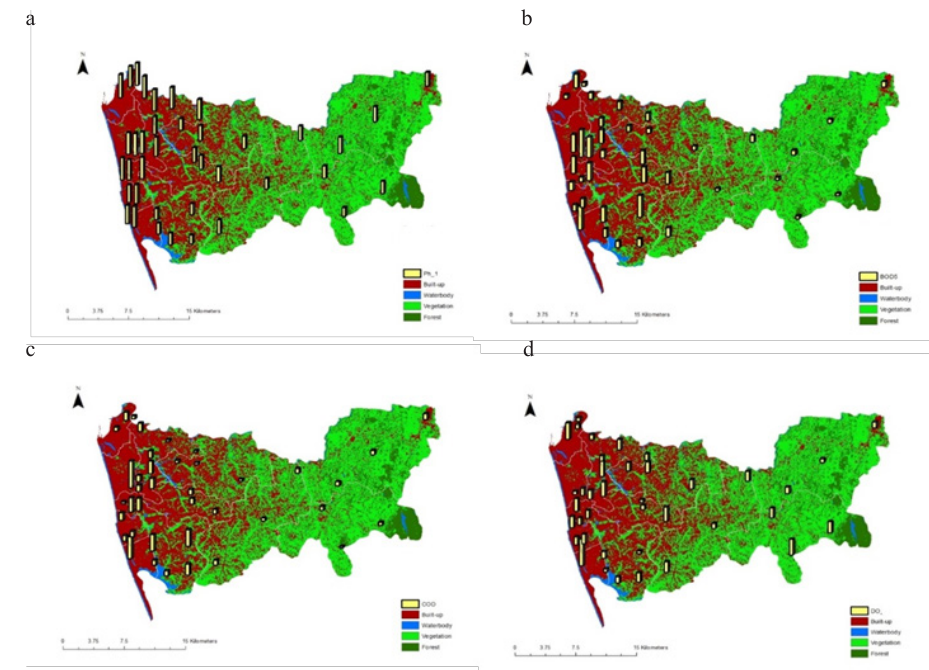
, (c) COD and (d) DO at the sampling points of 5